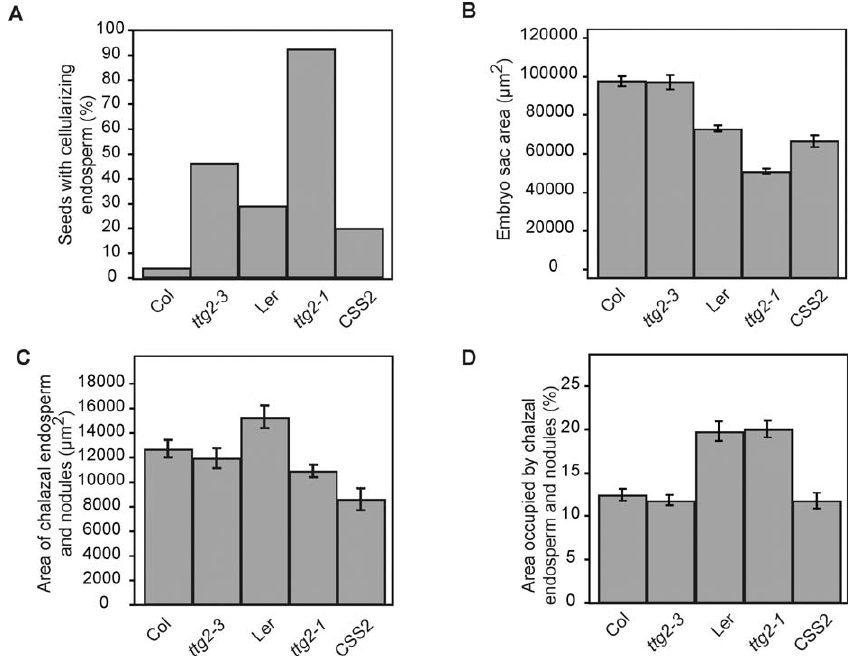
Figure 7. Endosperm Cellularization Is Associated with Interploidy Cross Success (A) Diploid seed parents were crossed to tetraploid Col. The percentage of seeds with cellularizing endosperm at 7–8 DAP ( y -axis) was quantified in cleared seeds. The genotypes of the diploid seed parents are indicated on the x -axis. (B) Crosses and seed clearing performed as in (A), but the plan area of the embryo sac was recorded. Means and standard deviations are displayed. (C) Crosses and seed clearing performed as in (A), but the plan area of the chalazal endosperm and endosperm nodules were recorded. Means and standard deviations per seed are displayed. (D) Data from (B) and (C) were used to calculate the percentage of the embryo sac area occupied by the chalazal endosperm and nodules in each seed. Means and standard deviations per seed are